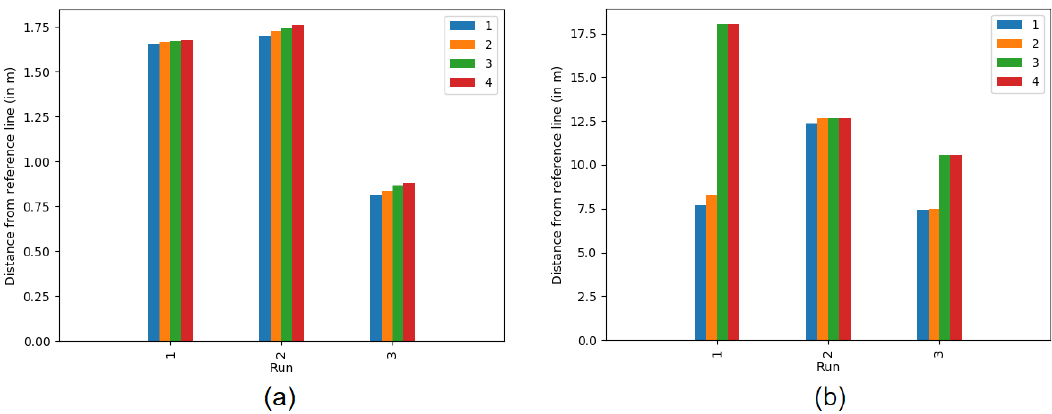
Figure A2. ( a ) Mean and ( b ) Maximum distance of the points passing Rule 2 from the reference